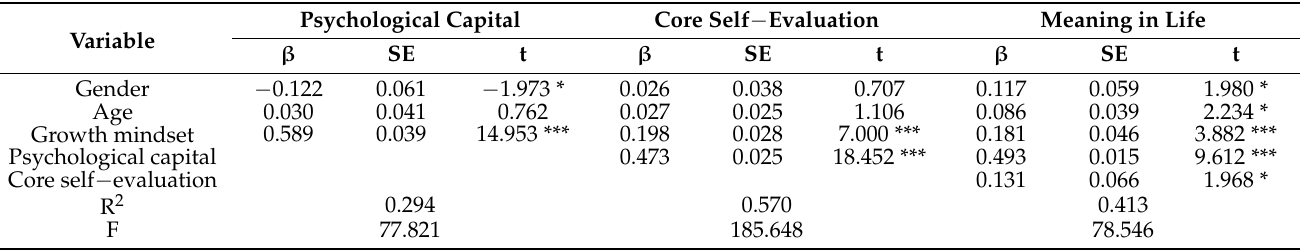
Table 2. Regression analyses results.